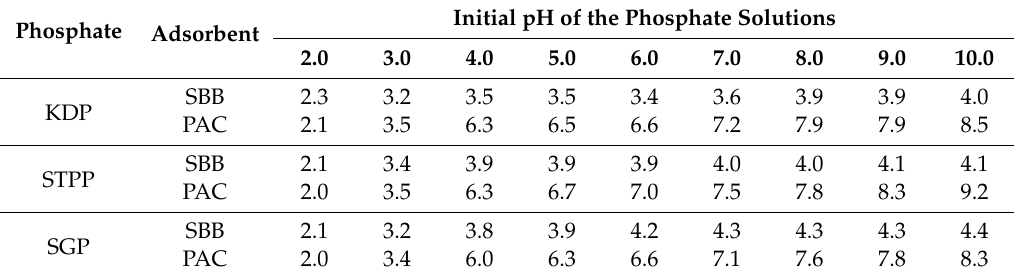
Table 2. Final pH of the phosphate solutions after